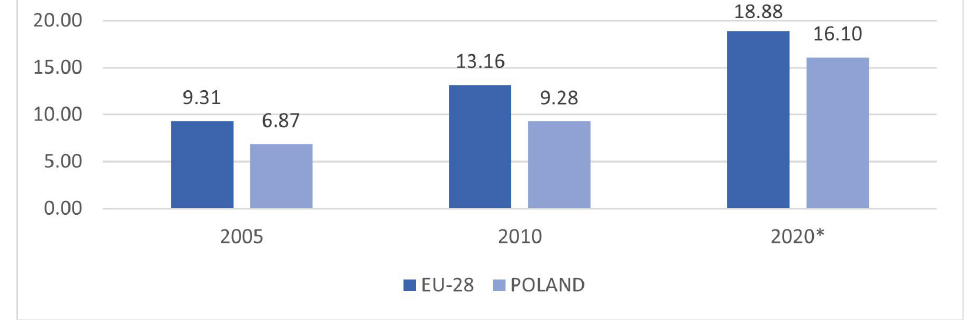
Figure 5. Share of electricity energy from RES in gross final consumption of energy in Poland, 2005–